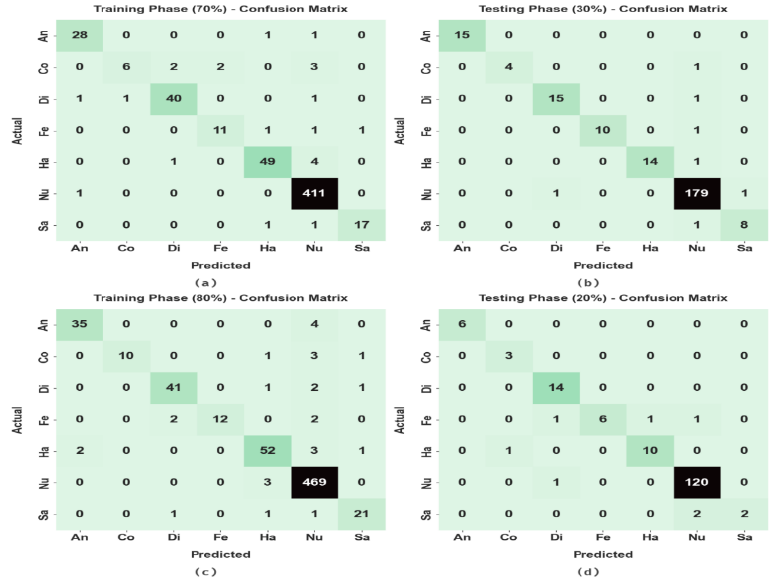
Figure 5. Confusion matrices of the RFER-EADL algorithm: ( a ) 70% of the TR dataset, ( b ) 30% of the